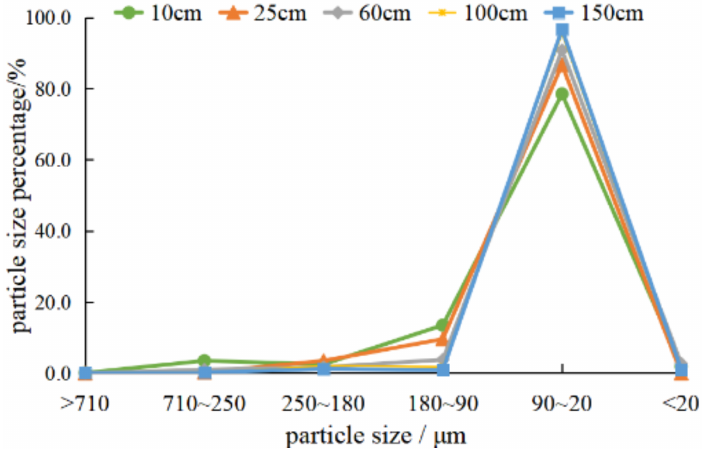
Figure 10. Huairou stubble + straw mulching.